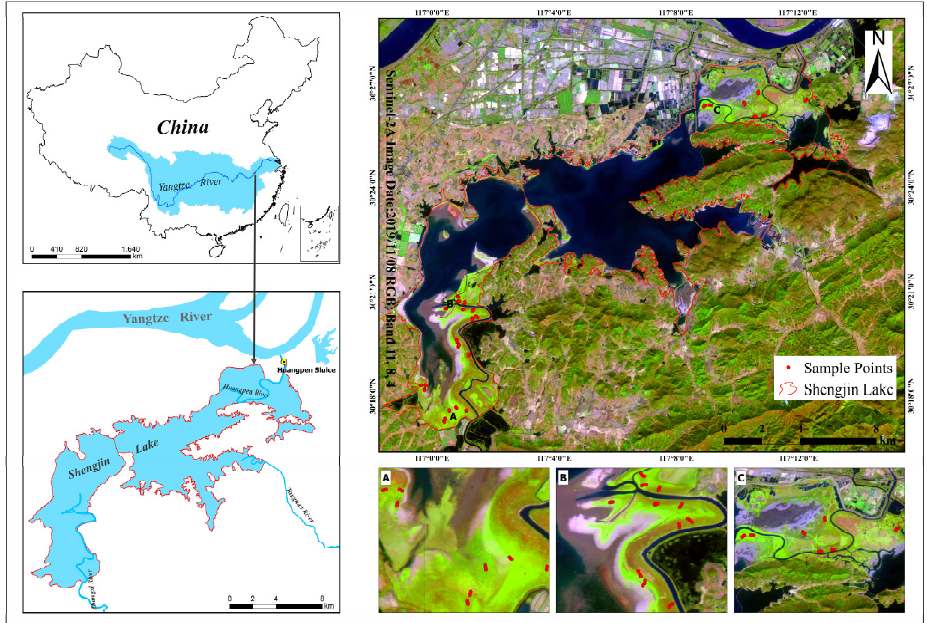
Figure 1. The location and scope of the Shengjin Lake wetland and the sampling quadrats distribu- tion in this region. ( A ) Zhouhe, ( B ) Yangetou, and ( C )